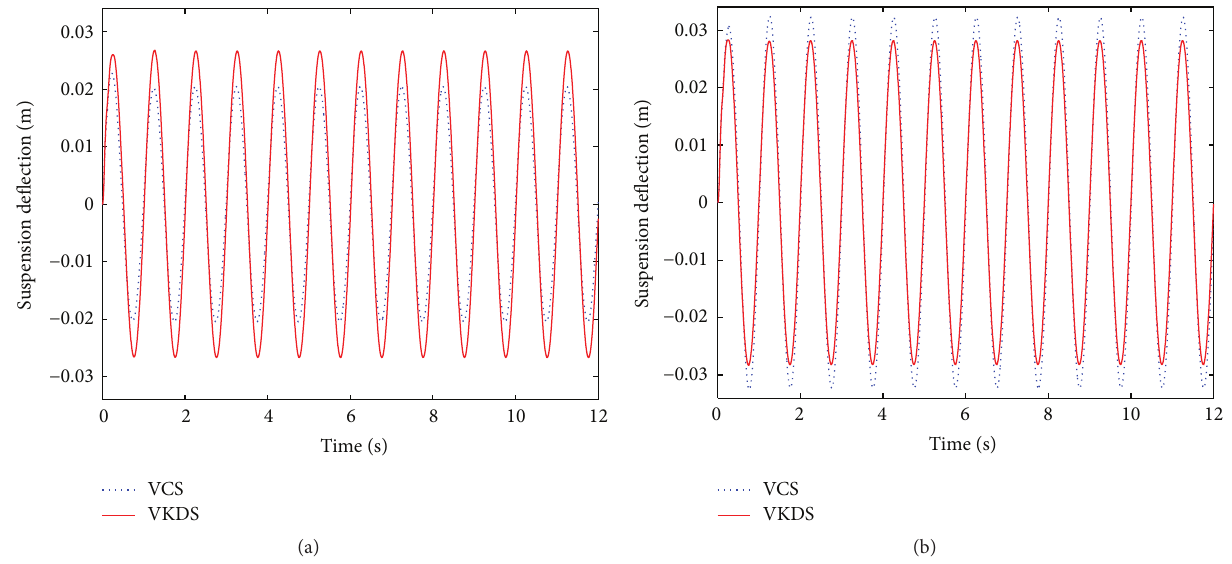
Figure 11: (a) Vehicle suspension deflection of the VCS and VKDS in front left station. (b) In rear right wheel